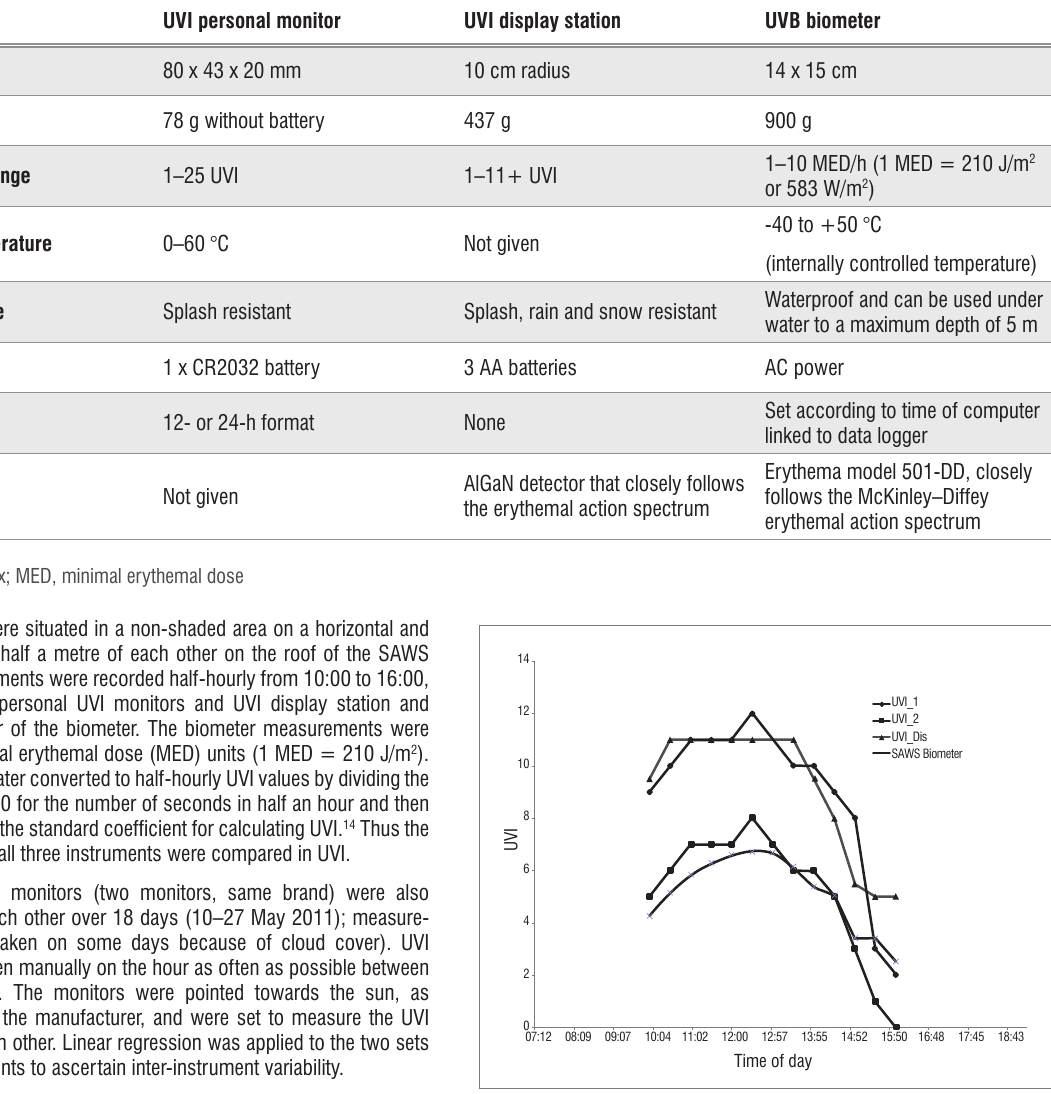
Figure 1: Diurnal pattern in the half-hourly readings of the UV index (UVI) made by two personal UVI monitors (UVI_1 and UVI_2), a UVI display station (UVI_Dis) and the biometer of the South African Weather Service (SAWS Biometer) on a clear-sky day (02 March 2012) in